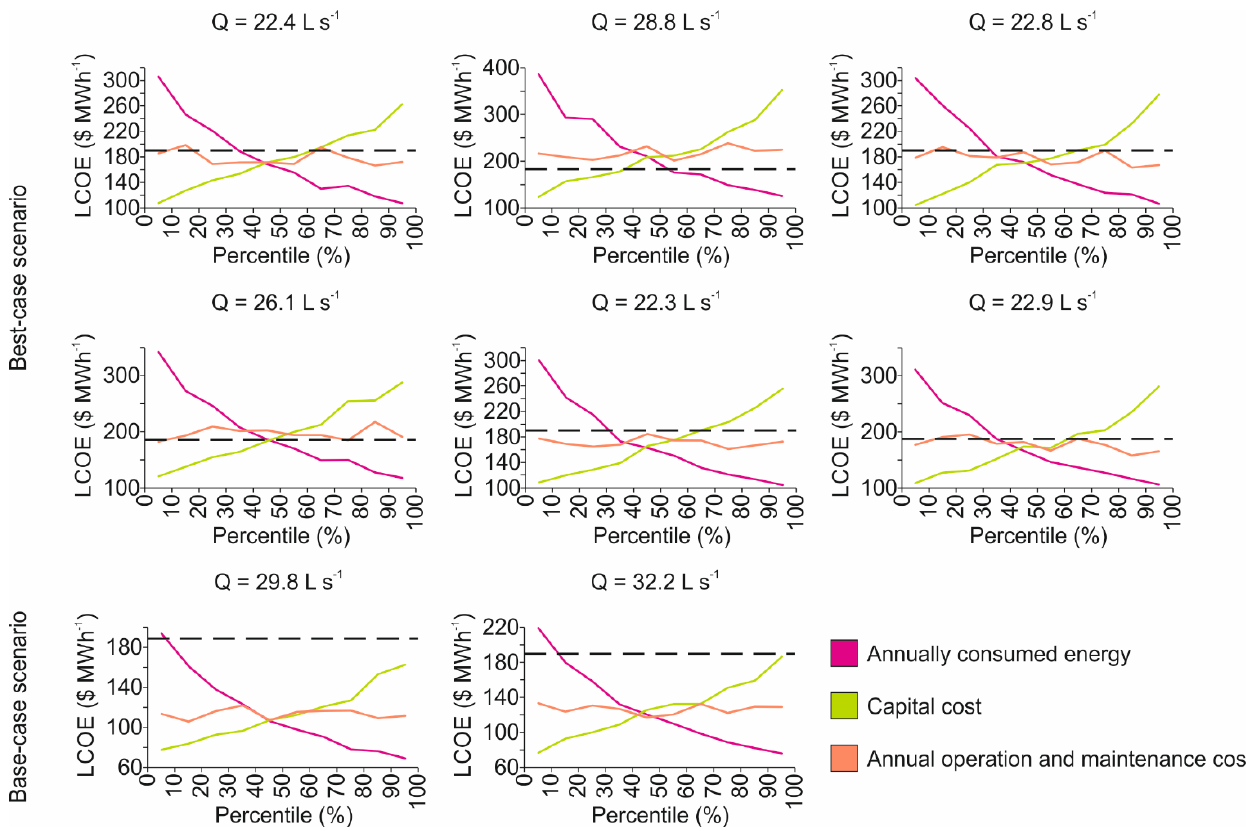
Figure 20. Levelized cost of energy as a function of the uncertain parameters’ percentile for configuration B. Dashed line—heating energy cost with oil furnaces (see text for further details). The reader is referred to Tables 4 and 5 for further details on the flow rates.